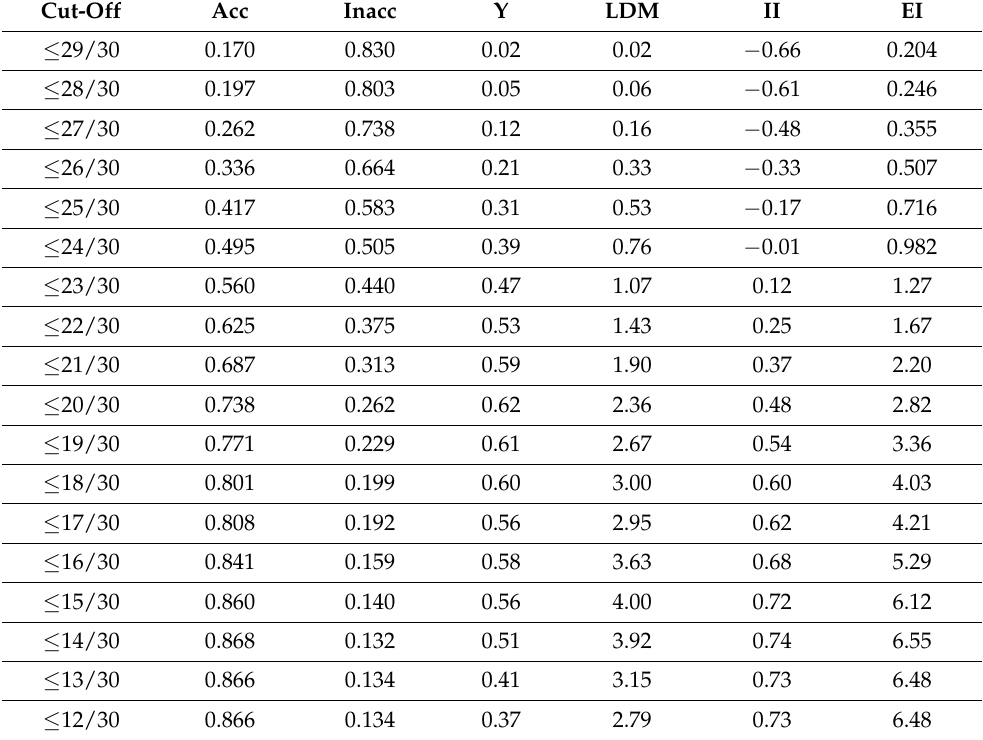
Table 3. Diagnosis of dementia: comparing metrics at various MACE